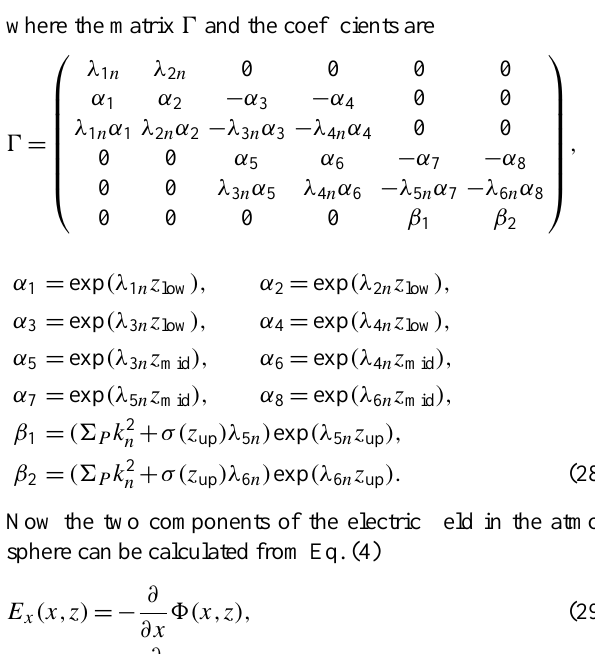
Fig. 3. Vertical electric field at the bottom of the ionosphere E z (x,z up ) is compared to the model E z (x,z up )/ 10 (Denisenko et al., 2008) (solid and dashed lines), with maximum values of 9.3µVm − 1 and 153µVm − 1 ,